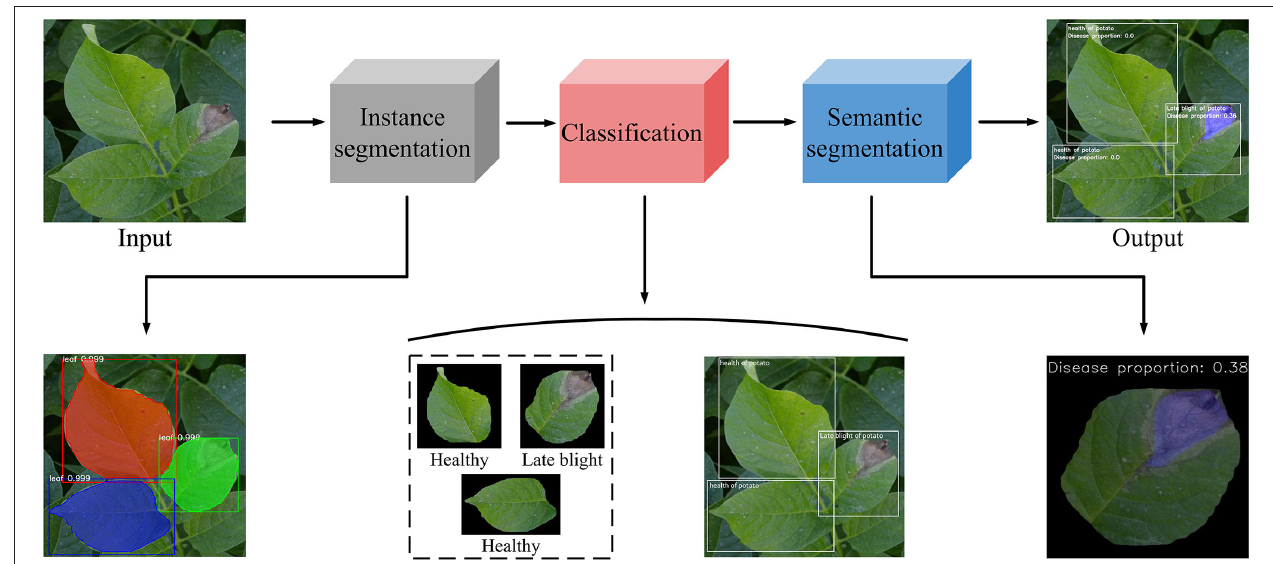
FIGURE 3 | The identification and classification of potato leaf process. This figure shows the whole experimental progress, from the input to the